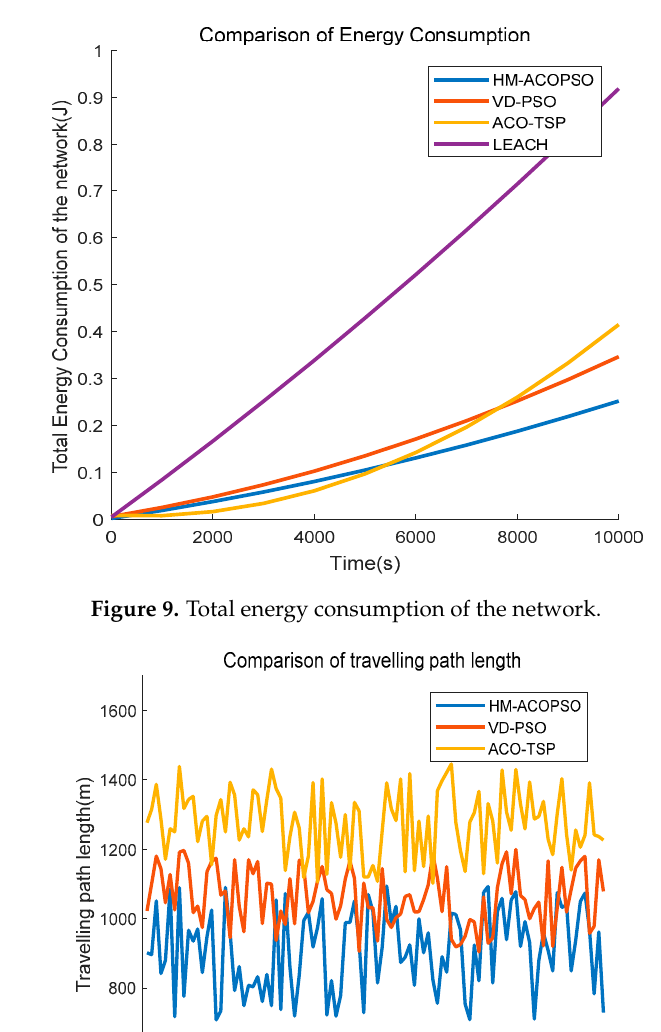
Figure 11. Overflowing data of the network. The input of PSO needs to use the output of ACO. Specifically, when we construct the particles P which represent anchor nodes, we need to use the sequence the ACO created to order the CHs. We also compare it with the anchor nodes ordered in a random way. The simulation result is shown as Figure 12. We can clearly see that the schema without ACO performs worse than the schema using ACO. The upper limit of the schema which doesn’t adopts ACO is close to twice that of the schema which adopts ACO. Even if the sets of anchor nodes in the two schemas are the same, when